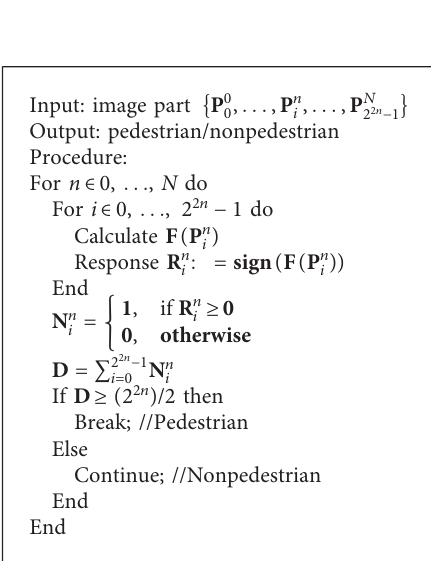
Figure 5: Flowchart of the pyramidal ensemble classifier